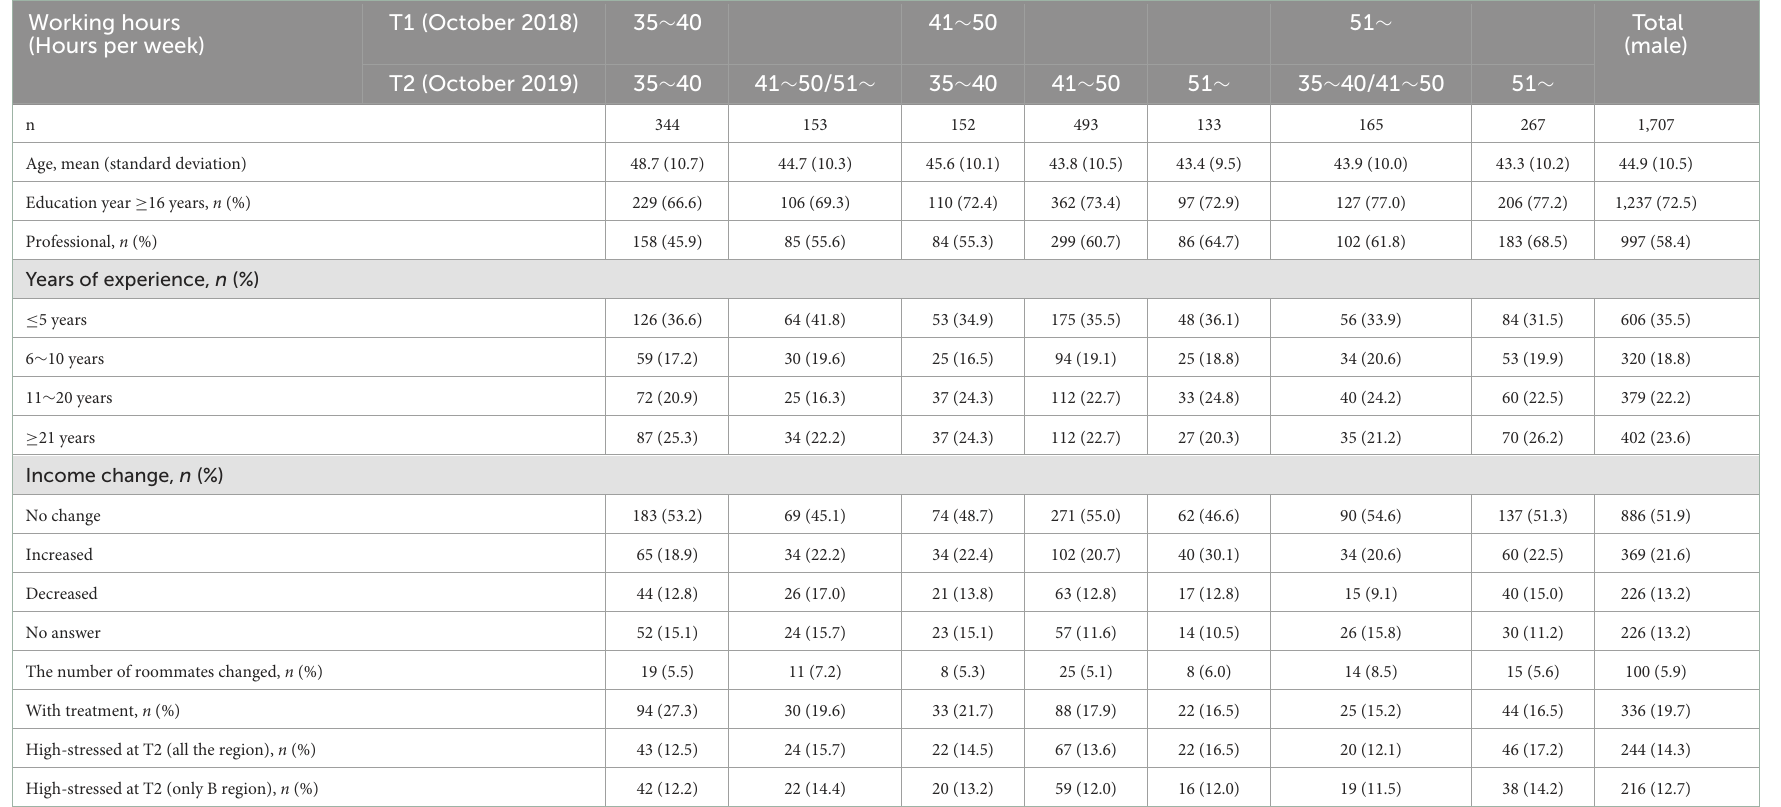
TABLE 2 Summary of backgrounds and characteristics of male